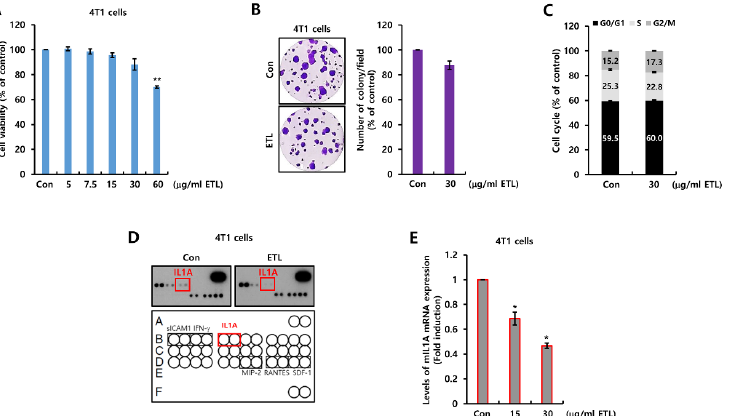
Figure 1. ETL downregulates mouse IL1A suppression in 4T1 TNBC cells. ( A – C ) after cell-seeding, 4T1 TNBC cells were treated with the indicated concentrations of ETL for 48 h ( A , B ) or two weeks ( C ). ( A ) cell viability was analyzed by the MTT assay. ( B ) the cell cycle was analyzed by flow cytometry. ( C ) cell proliferation was analyzed by the colony-forming assay. ( D ) after 24 h of serum starvation, the cells were treated with or without 30 µ g/mL ETL for 24 h. We harvested the conditioned cell culture media and then analyzed mouse cytokines. ( E ) the expression of mIL1A mRNA was analyzed by real-time PCR. The values are presented as the mean ± standard error of three independent experiments. * p < 0.05, ** p < 0.01 vs. Con. Con; control, ETL; Entelon ® , mIL1A; mouse